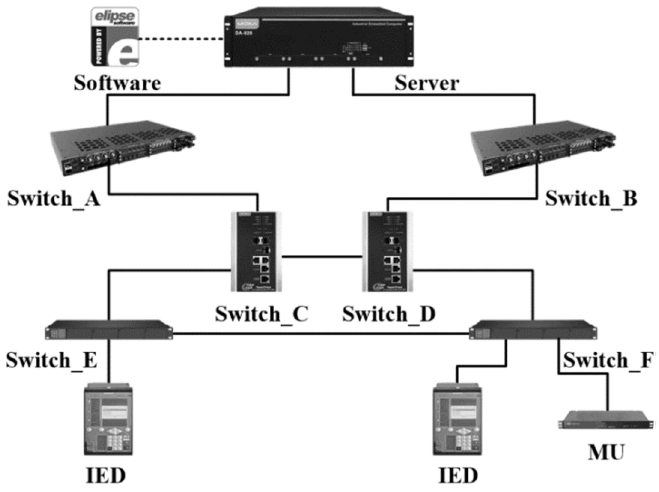
Figure 1. Schematic diagram illustrating a generalized form of CBM Platform.